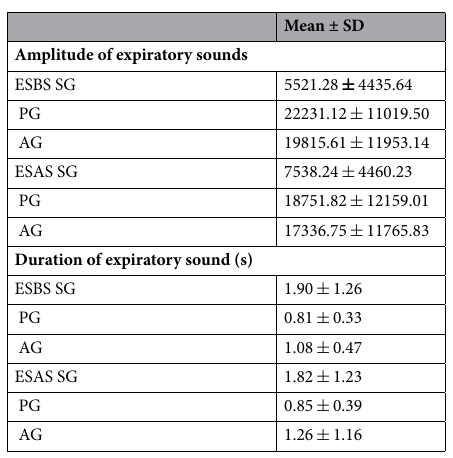
Table 2. Amplitude of expiratory sounds.